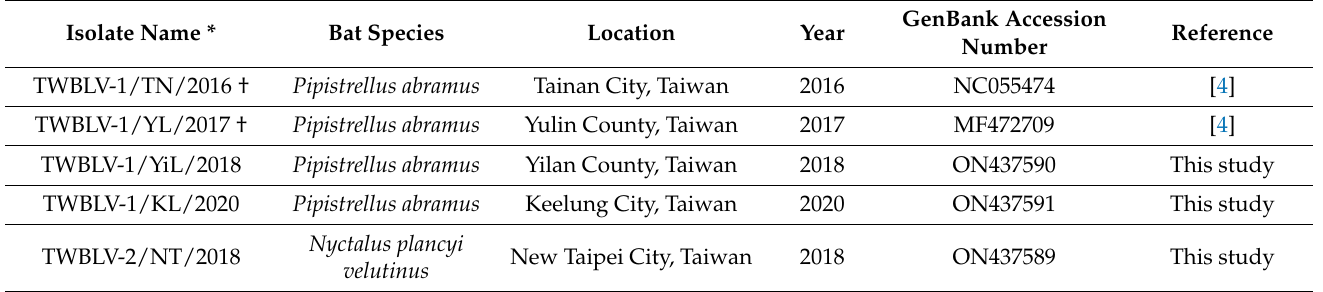
Table 1. The Lyssaviruses isolated in bats in Taiwan during passive